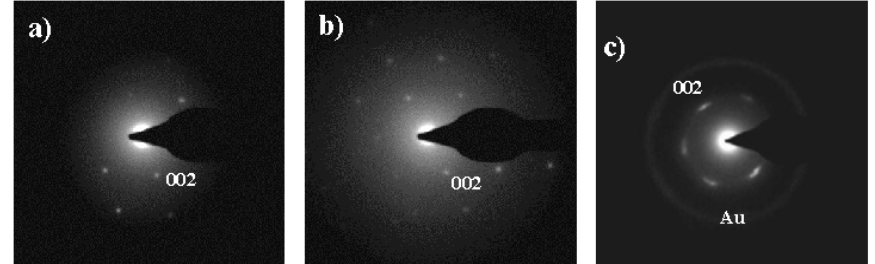
Figure 18. Selected-area electron diffraction pattern of nylon 4 9 spherulites crystallized at: 229 °C ( a , b ); and 238 °C ( c ). Patterns corresponded to the low temperature structure observed from solution crystallized samples. Symmetry is usually lost in the patterns coming from spherulites crystallized at 229 °C ( a ) as consequence of lamellar twisting, although a 2 mm symmetry can also hardly detected ( b ). This symmetry is more easily observed from spherulites attained at the higher temperature as a consequence of a flat-on lamellar disposition ( c ).